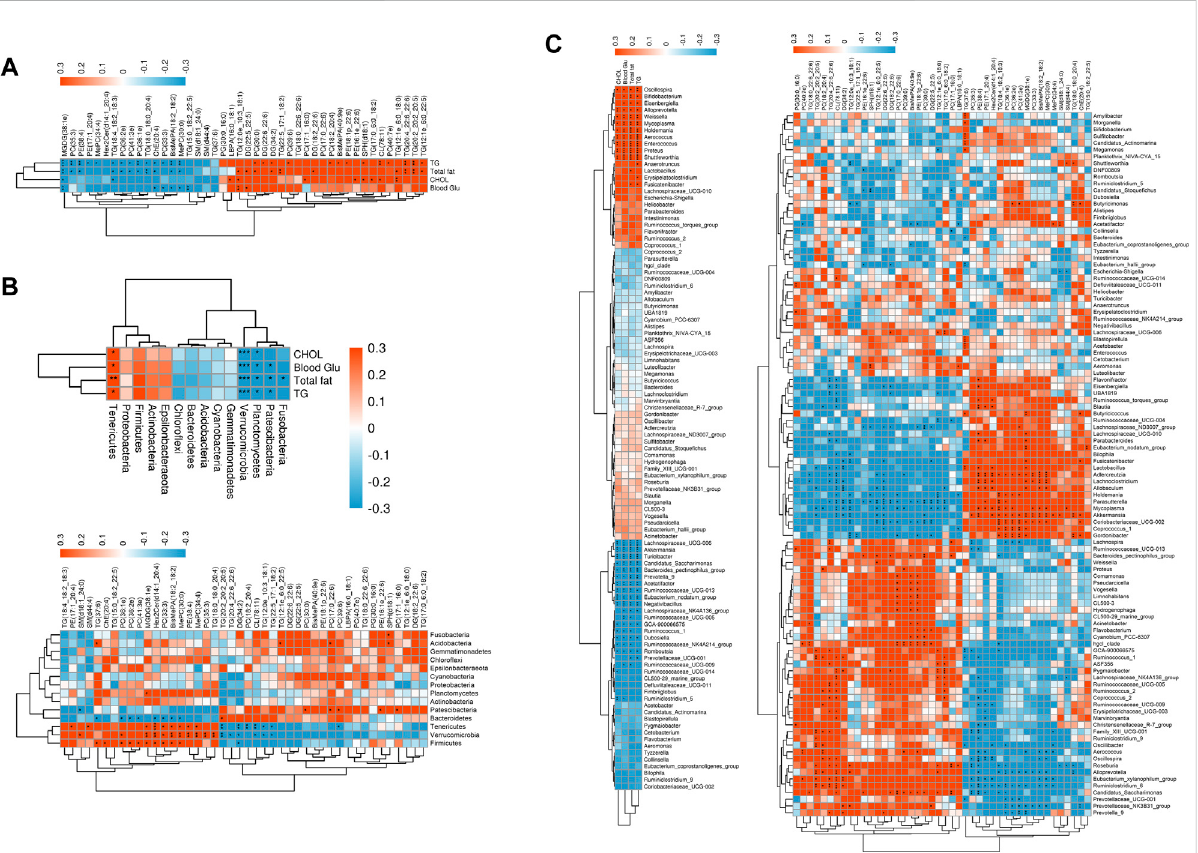
FIGURE 11 BYHWD improved the metabolic pattern and the level of the differential lipids induced by the T2DM model: (A) the heatmap of the differential lipids between the DM and DM + BYHWD groups; (B) the heatmap of the differential lipids between the DM and DM + DMBG groups; (C) KEGG enrichmentpathwaysofsigni fi cantdifferentiallipidsintheDM+BYHWD groupwhencompared withthatintheDMgroup; (D) signi fi cantmetabolic pathways map in the DM + BYHWD group when compared with that in the DM